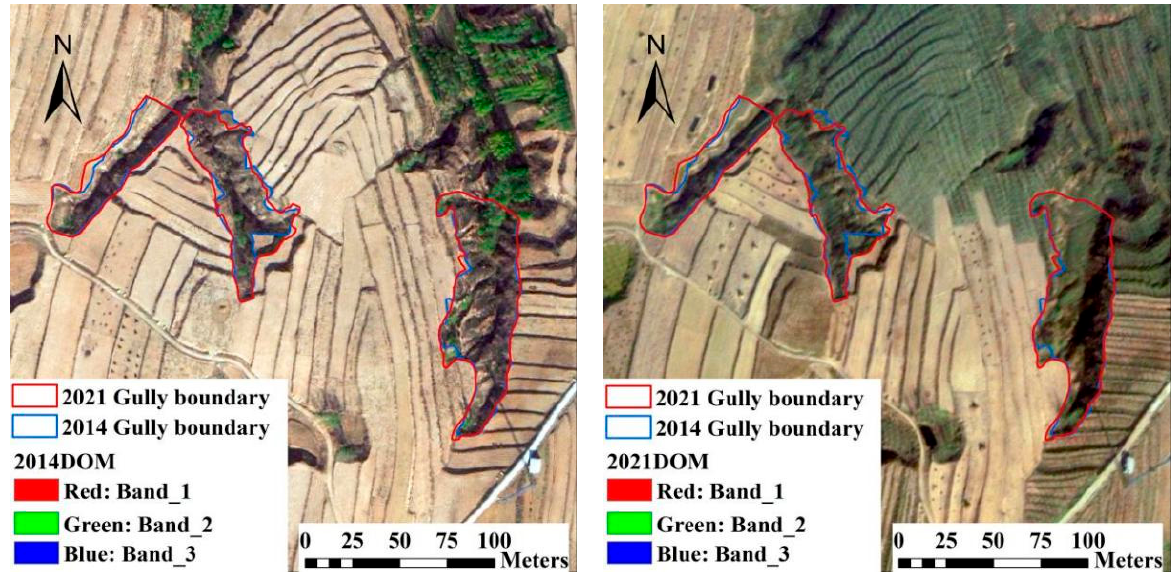
Figure 7. An example of gully width increase.